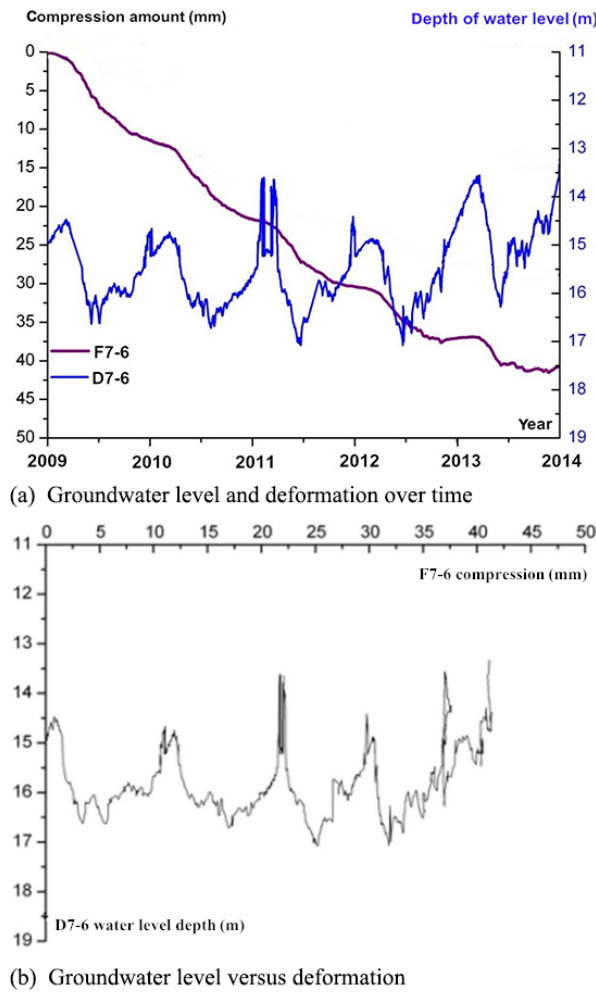
Figure 7. Comprehensive map of the layered compression quantity and compression ratio for monitoring station A (2009–2014).